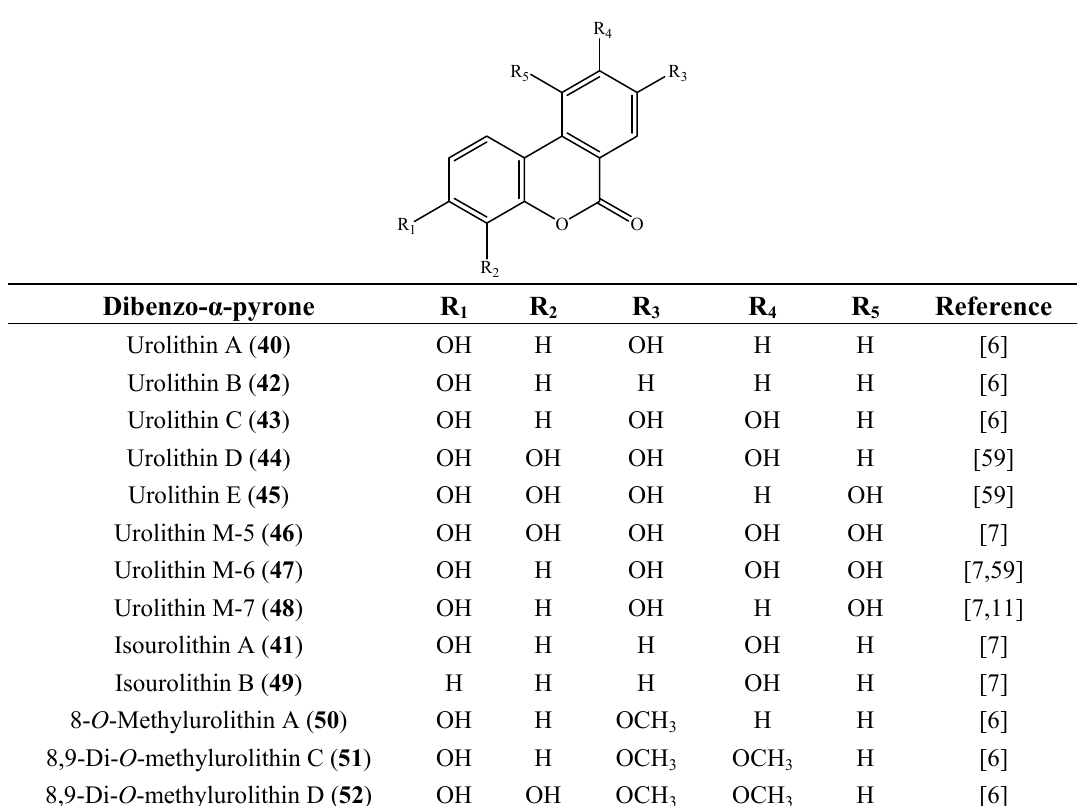
Figure 3. Dibenzo- α -pyrones produced by transformation of intestinal